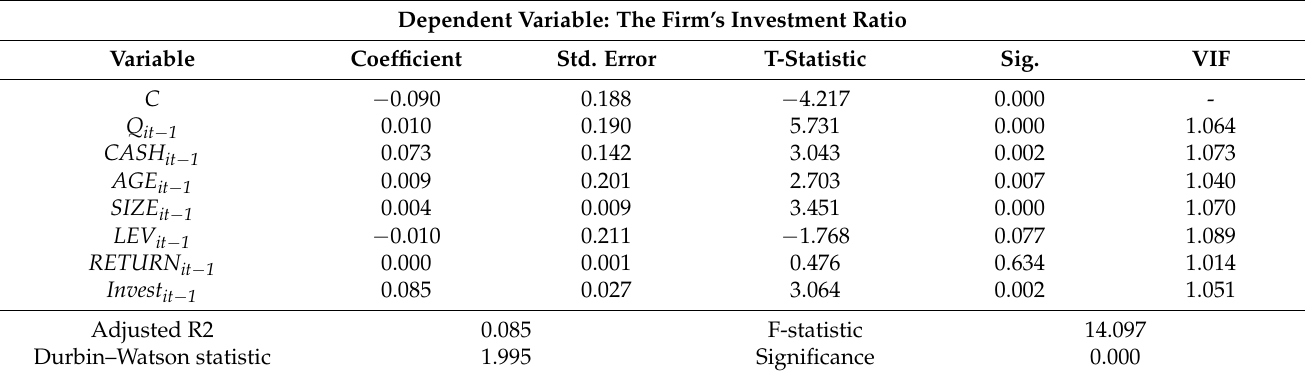
Table 7. Results of the statistical test of the investment efficiency